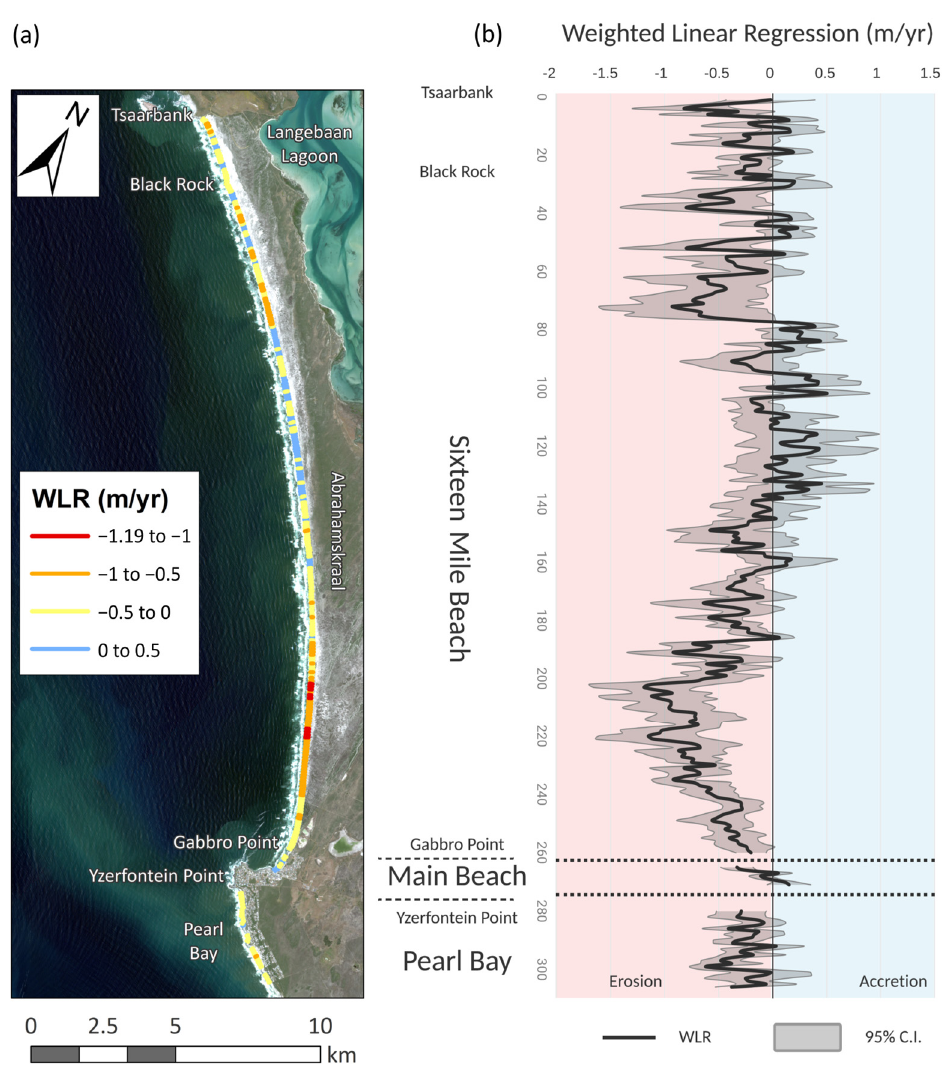
Figure 5. ( a ) Map of the Weighted Linear Regression rates along the study site with warm colors representing erosion and cool colors representing accretion. ( b ) Graph of WLR at every 100 m transect along the coast and the 95% confidence interval.